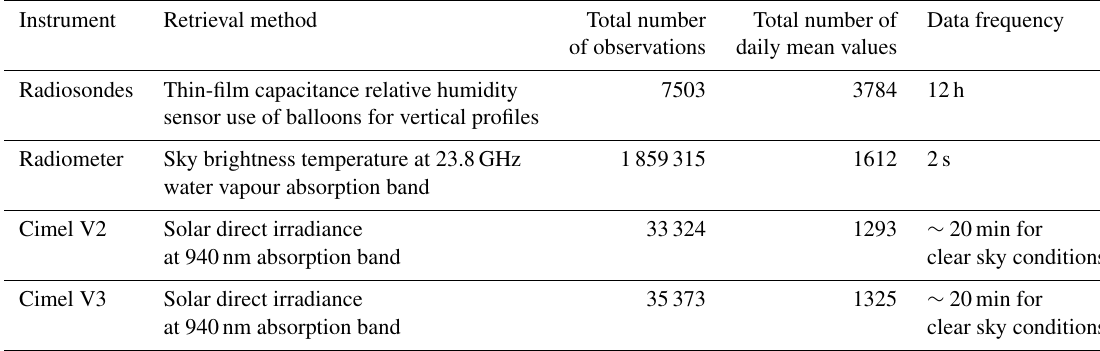
Table 1. Overview of the measurement characteristics and datasets used in this study for the period 2007–2017.